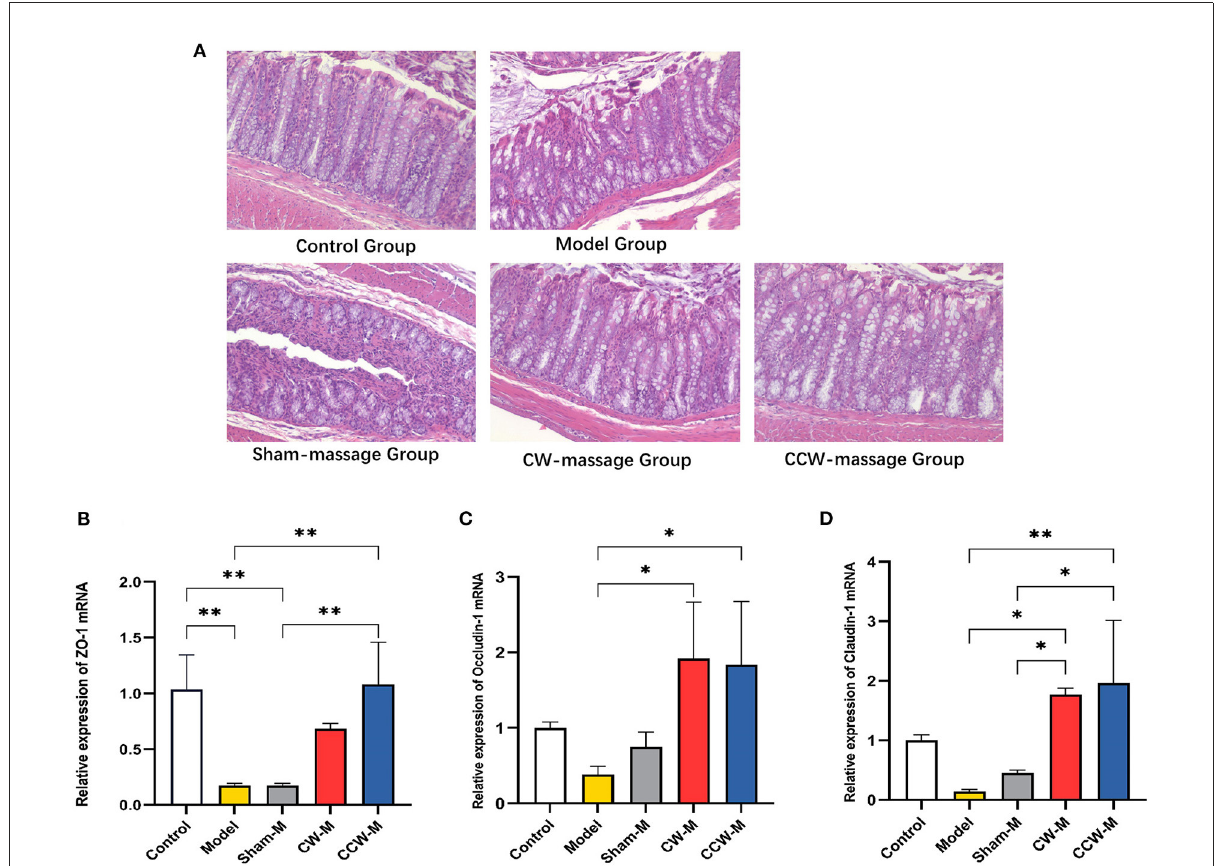
FIGURE3 (A) H&E staining of colon tissue sample sections of rats. (B–D) Relative expression of ZO-1, Occludin-1 and Claudin-1 mRNA in colon was assessed using RT-qPCR. Error bars are expressed as means ± SD ( n = 3). Statistical significance was determined by one-way ANOVA with